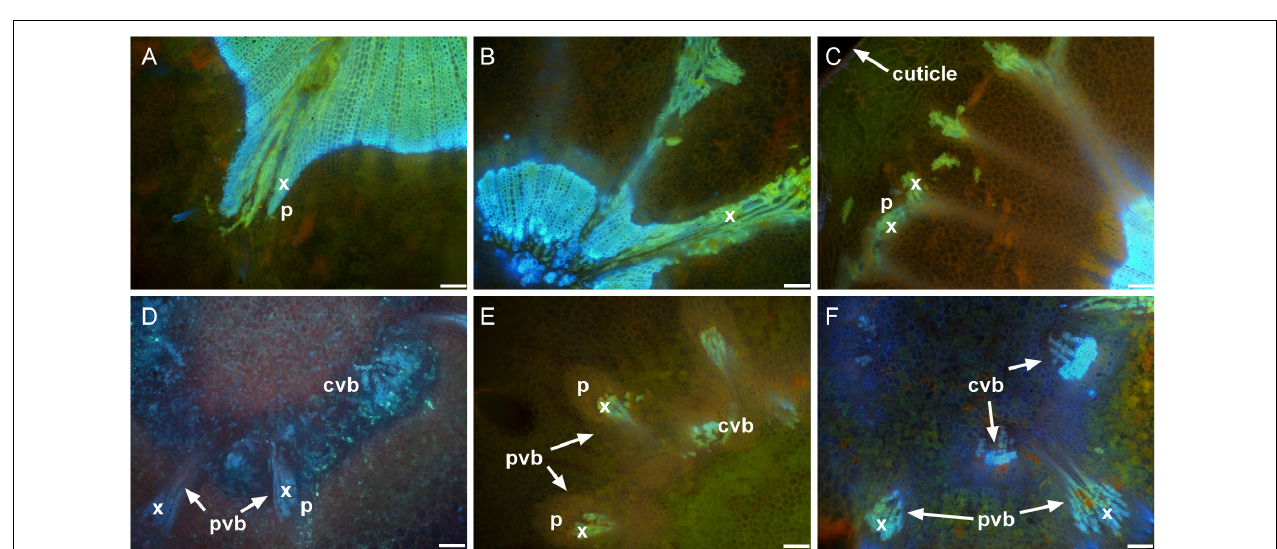
FIGURE 6 | Sections of receptacles (A,E) , receptacle/berry junction (B,F) , brush zone 1 (2–4 mm from junction) (C,G) , brush zone 2 (4–6 mm from junction) (D,H) , stained with aniline blue fluorochrome and imaged under UV, of fresh berries of Shiraz BVRC12 (A–D) and Flame Seedless (E–H) at around 65 days after anthesis (post-veraison), in the 2018/2019 season. Blue color indicates lignin (xylem and phloem fiber). Bright fluorescent greenish blue indicates callose formed within the sections and primarily within phloem, red tint in images indicates chlorophyll (x, xylem; p, phloem; r, xylem ray; f, phloem fiber). Excitation filter 330–385 nm, dichroic mirror 400 nm, barrier filter 420 nm. Scale bar = 100 µ